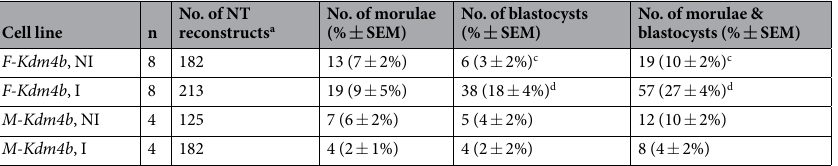
Table 2. In vitro development of NT reconstructs. NI = non-induced, I = induced; a all data relate to reconstructs that extruded a single polar body and were cultured until day 4; cd Values within different superscripts within a column differ with P <